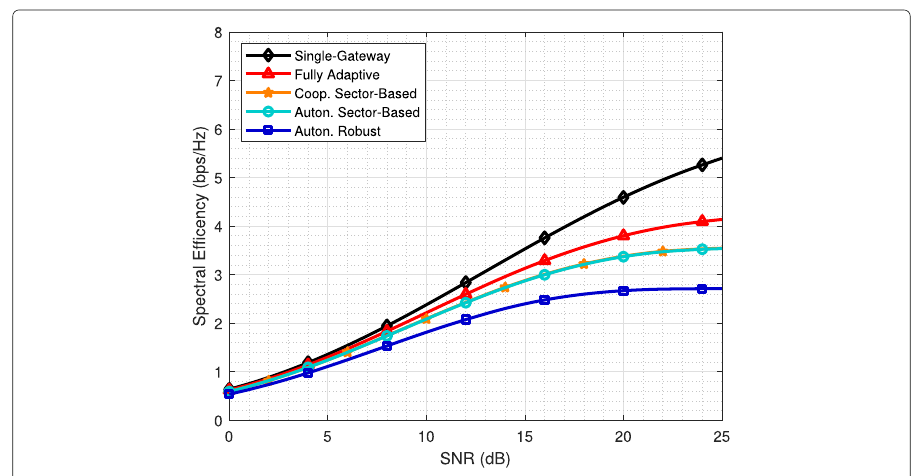
Fig. 11 Numerical results for 3 users per frame